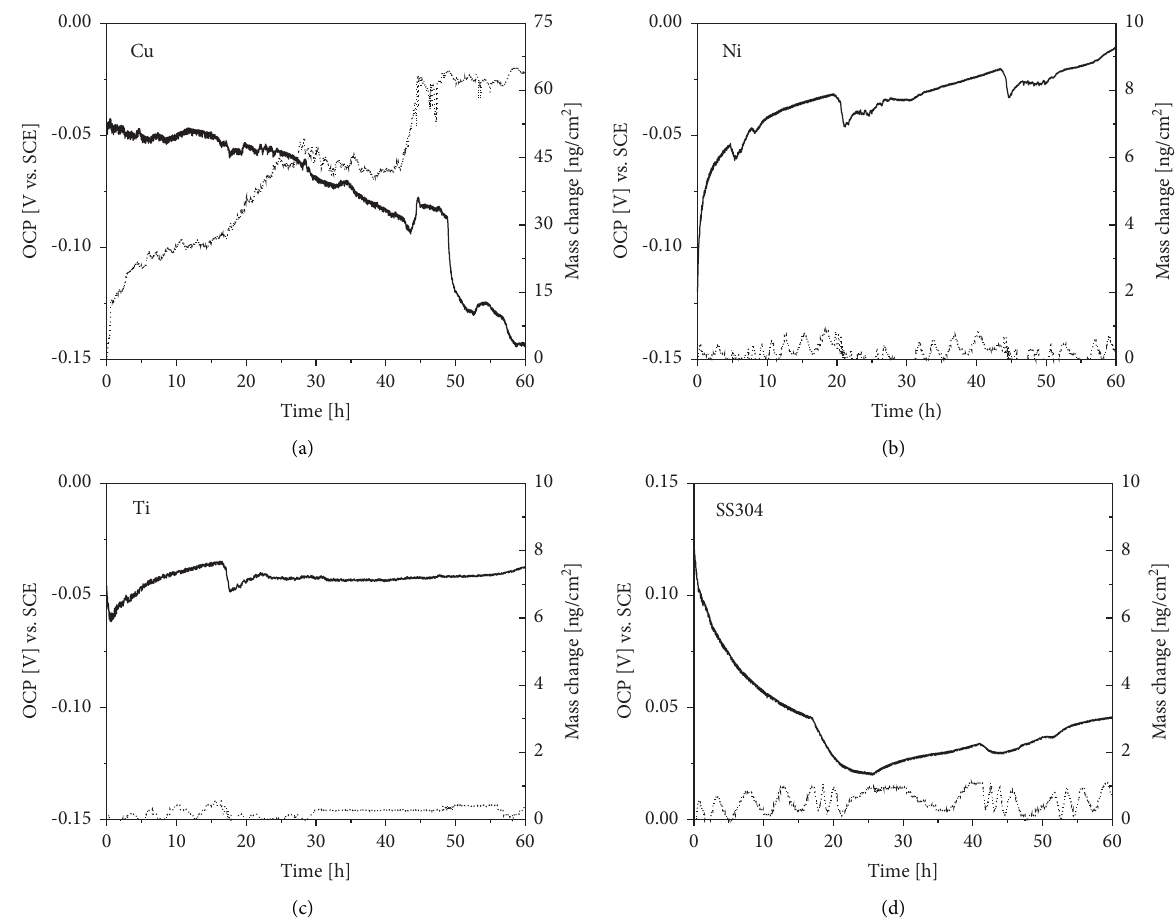
Figure 2: OCP (solid line) and mass change (dash line) of (a) Cu, (b) Ni, (c) Ti, and (d) SS304 in oxic KURT groundwater